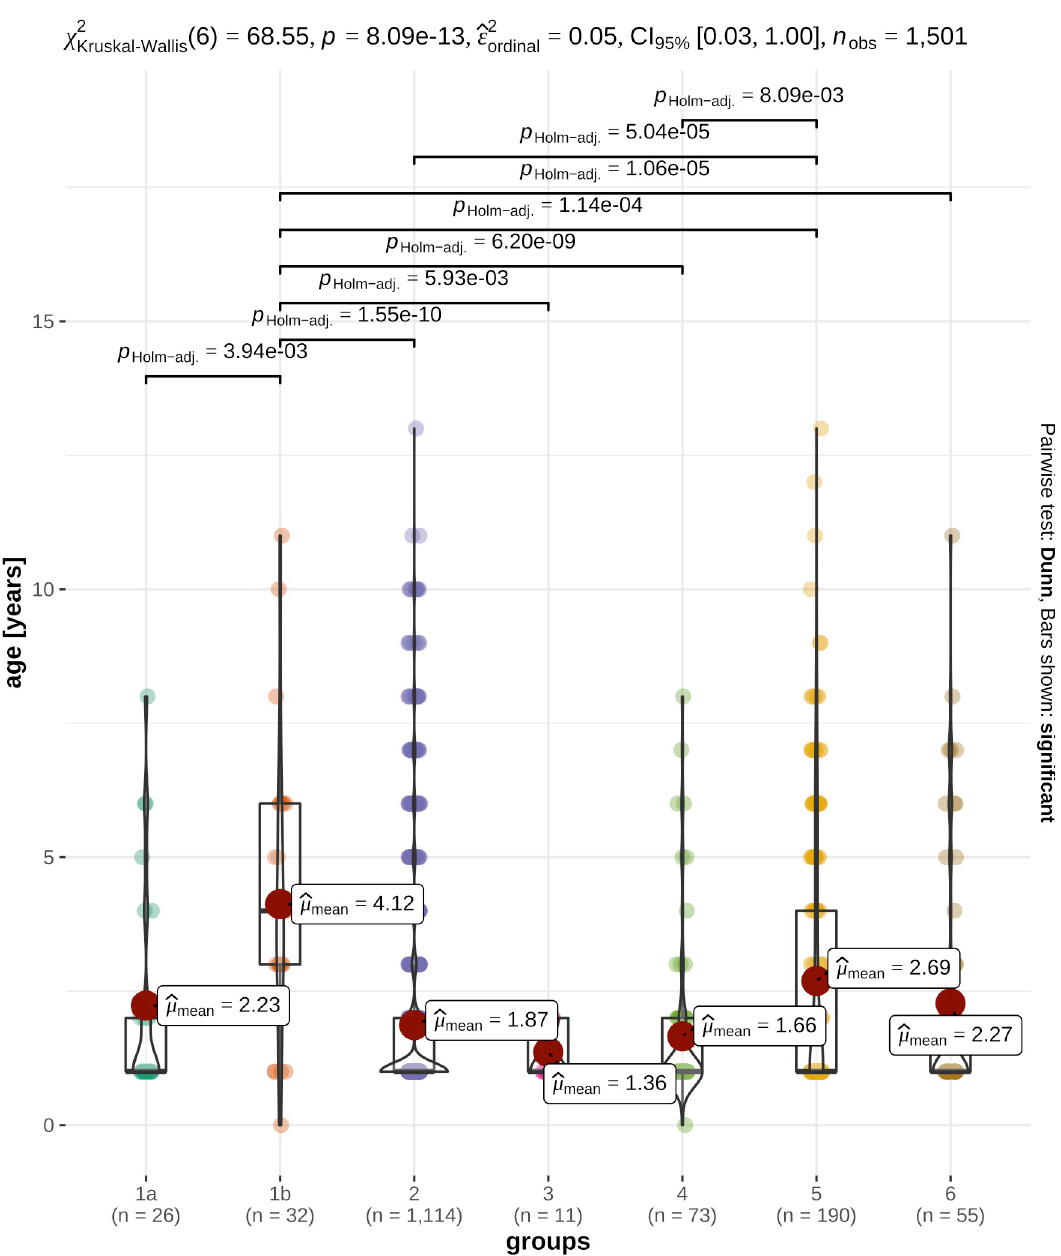
Fig 2. Box and violin plots illustrate the distribution of age in the different groups. TgAA-positive hypothyroidism (group 1a), TgAA-negative hypothyroidism (group 1b), euthyroidism (group 2), subclinical hypothyroidism (group 3), TgAA-positive dogs with unremarkable thyroid function (group 4), potential nonthyroidal illness (group 5), unclassified dogs (group 6). The x-axis shows the different groups, and the y-axis represents the age of the dogs in years. The p value of 8.09e-13 (p < 0.001) (in the first line of the graphic) provides very strong evidence that at least one of the groups is different from the others [45]. However, partial epsilon squared ( ^ ε ^2 ) with a 95% CI as the measure of the effect size for Kruskal–Wallis test is 0.05. This finding indicates that the effect of ordinal the groups on the age distribution is minimal [45]. Using Dunn pairwise tests, the displayed p values illustrate the groups between which a significant difference exists [45]. A significant difference in the age distribution was noted in group 1b (TgAA-negative hypothyroidism) compared with all the other groups (1b/1a, 1b/3, p < 0.01; 1b/2, 1b/4-6, p < 0.001), between group 5 (potential nonthyroidal illness) and groups 2 (p < 0.001) and 4 (p <